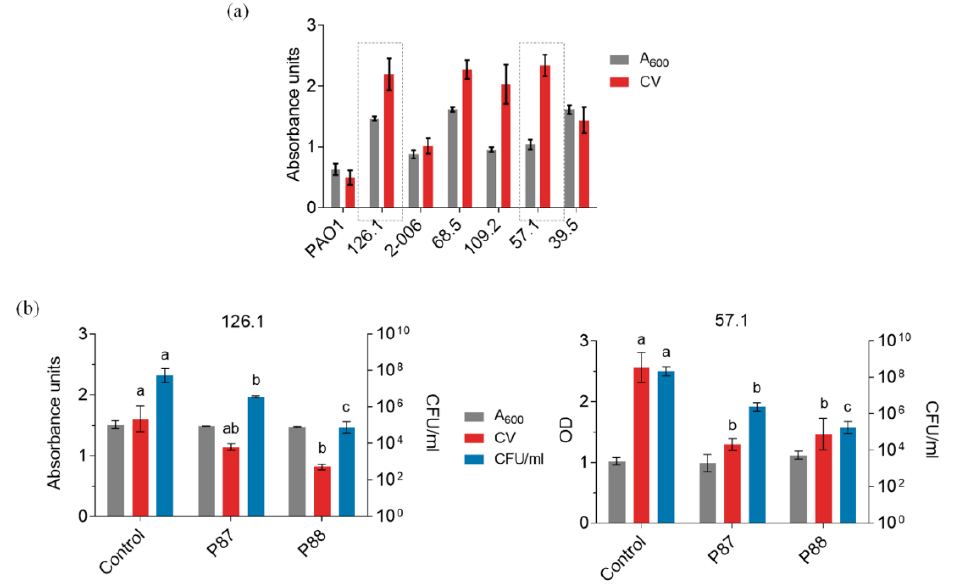
Figure 5. Activity tests of Pae87 derivative peptides against P. aeruginosa biofilms. ( a ) Evaluation of the biofilm formation capacity of our available clinical P. aeruginosa strains. ( b ) Biofilm disaggregation assays of P. aeruginosa strains 126.1 and 57.1 with 10 µ M of different compounds applied for 2 h at 37 ◦ C. ANOVA followed by Tukey’s post-test was used to determine significant differences between treatments comparing all-against-all the different conditions (Control, P87, P88) within each type of measurement. Different letters indicate significant differences with a p -value of at least ≤